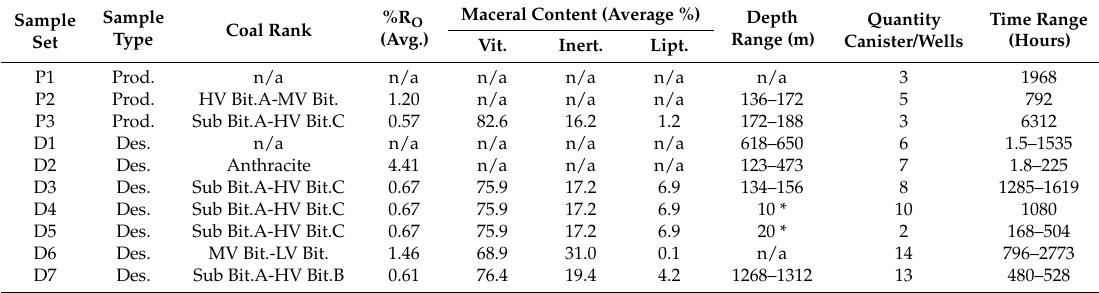
Table 1. Coal characteristics and information about type and duration of used sample methods. Sample